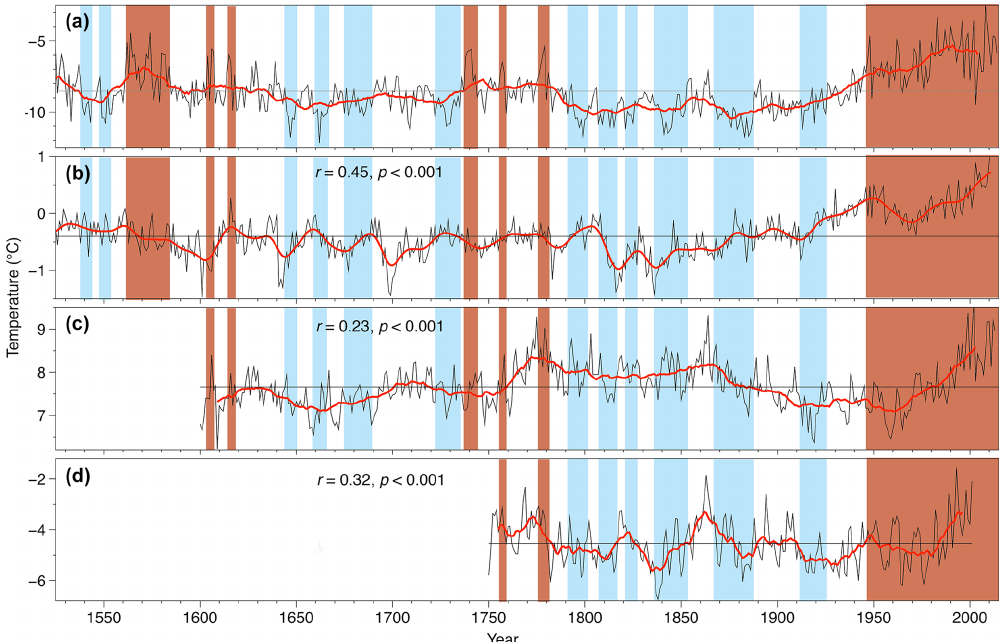
Figure 8. (a) August–December mean minimum temperature reconstructed (VUSr) for the southern part of Sikhote-Alin, (b) Northern Hemisphere extratropical temperature (Wilson et al., 2016), (c) April–July minimum temperature on Laobai Mountain by Lyu et al. (2016), and (d) February–April temperature established by Zhu et al. (2009) in the Changbai Mountains. Black lines denote temperature recon- struction values, and red lines indicate the 21-year moving average; red and blue fields show warm and cold periods, respectively (in this